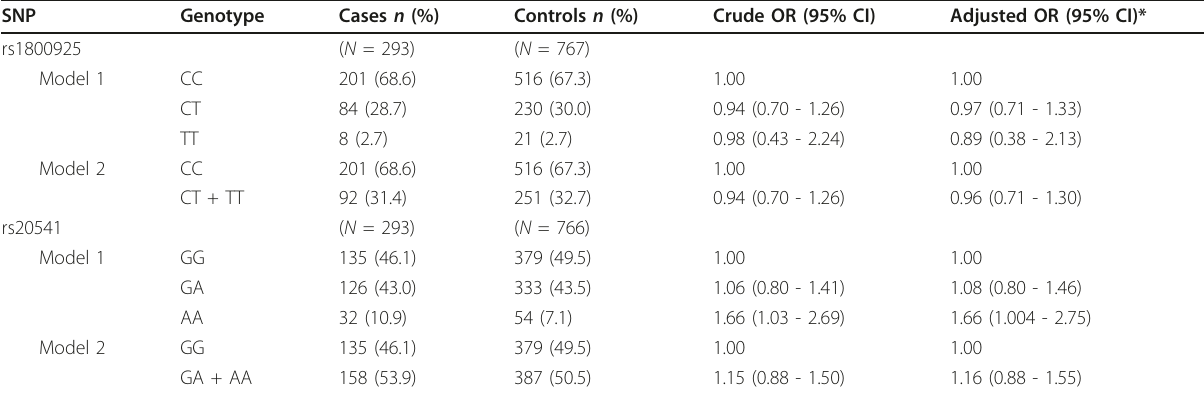
Table 3 Odds ratios (ORs) and 95% confidence intervals (CIs) for doctor-diagnosed allergic rhinitis according to IL13 polymorphisms in Japanese women, KOMCHS,